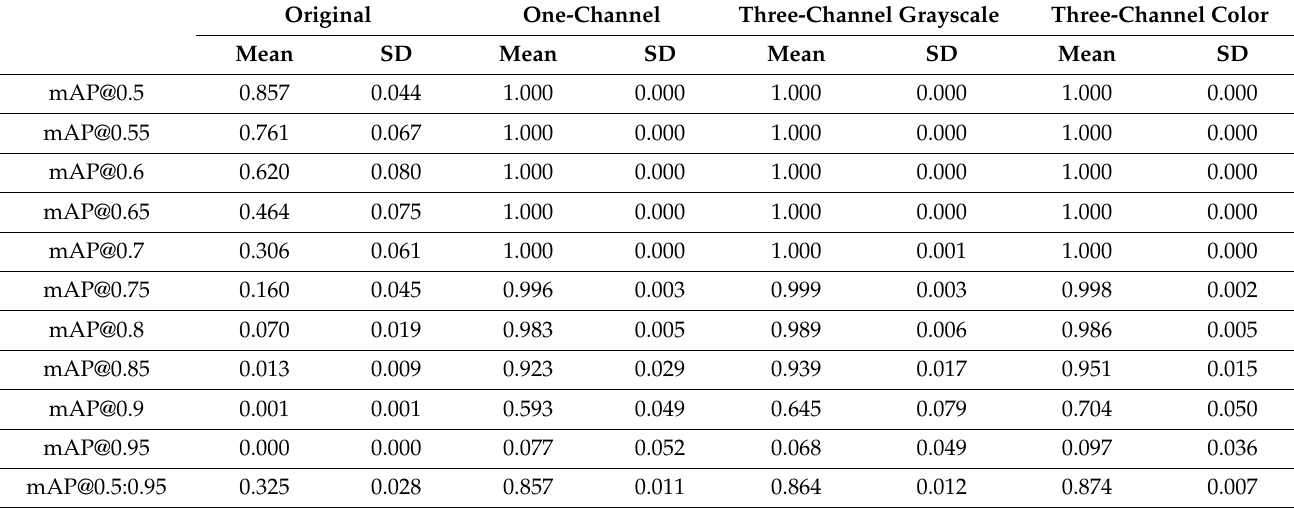
Table 13. YOLOv4-tiny object detection validation results with the original dataset.